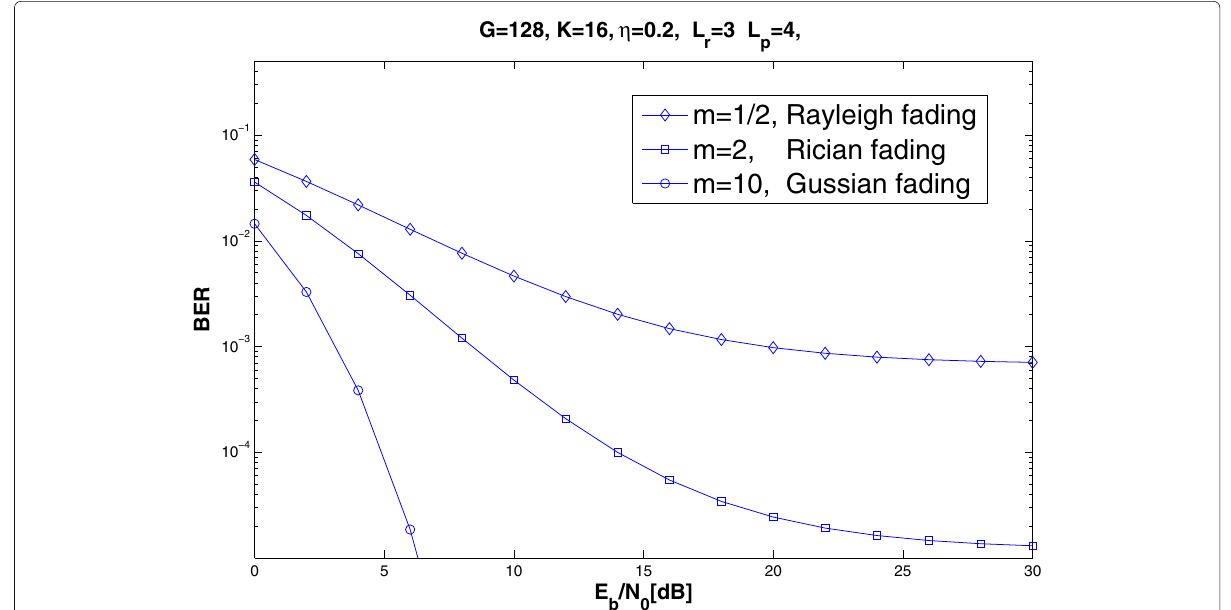
Fig. 9 BER performance of the CDD communication system in adjunction with different fading channel